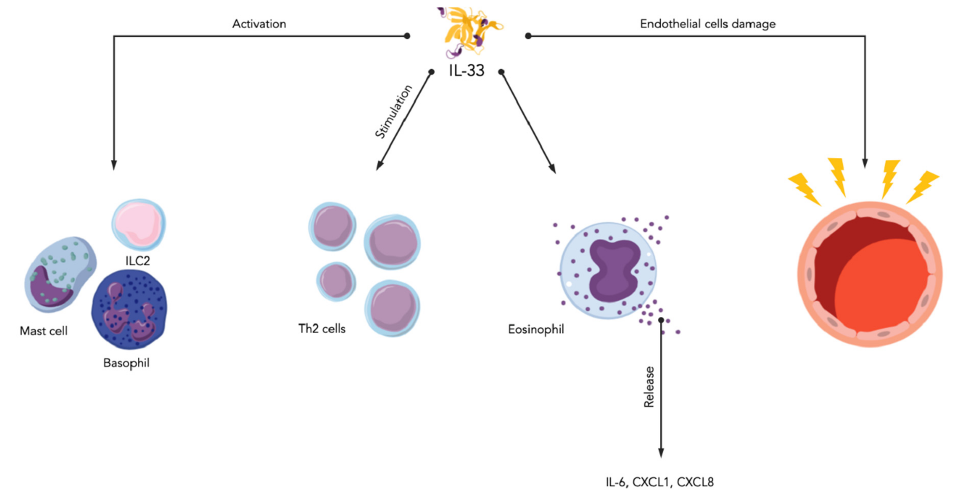
Figure 1. Involvement of IL-33 in asthma. IL-33 stimulates cells of the immune system (ILC2s, mast cells, Th2 cells, eosinophils, and basophils) to release pro-inflammatory cytokines and chemokines. IL-33 also causes endothelial cell damage.